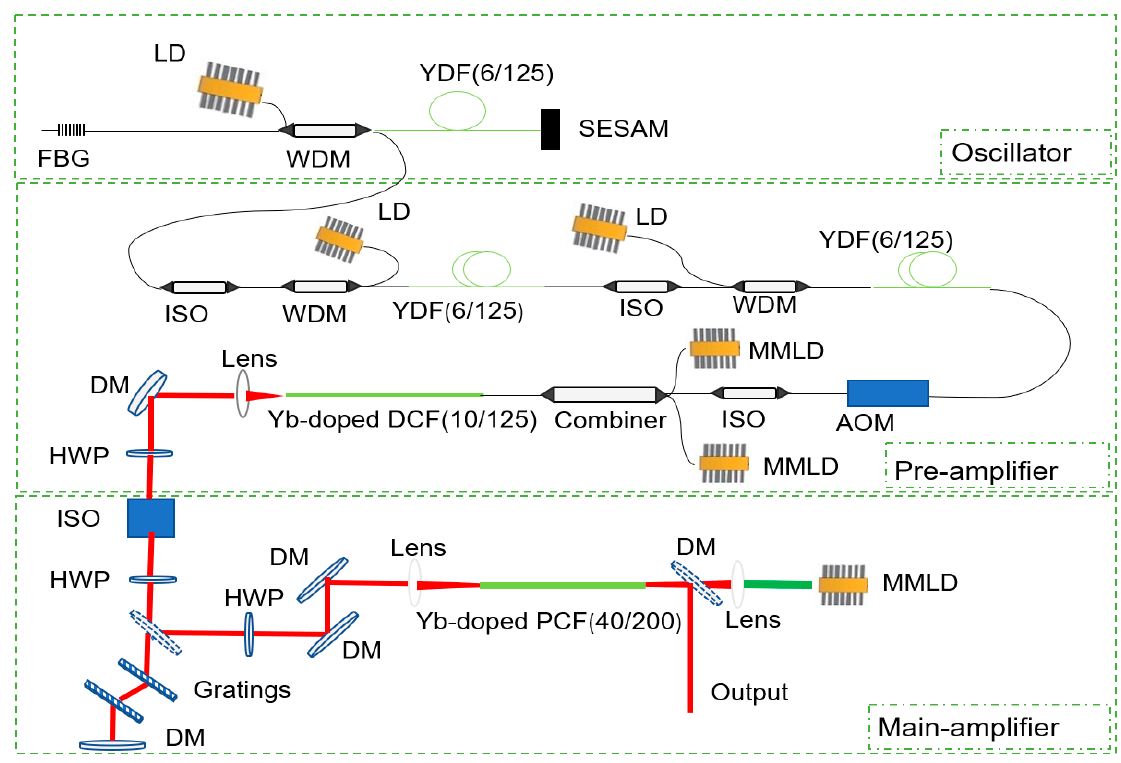
Figure 1. Schematic diagram of the laser system. FBG, fiber bragg grating; ISO, isolator; LD, laser diode; WDM, wavelength division multiplexer; YDF, Yb-doped fiber; DCF, double-clad fiber; PCF, photonic crystal fibers; MMLD, multi-mode laser diode; DM, dichroic mirror; HWP, half wave plate; AOM, acousto-optic modulator.